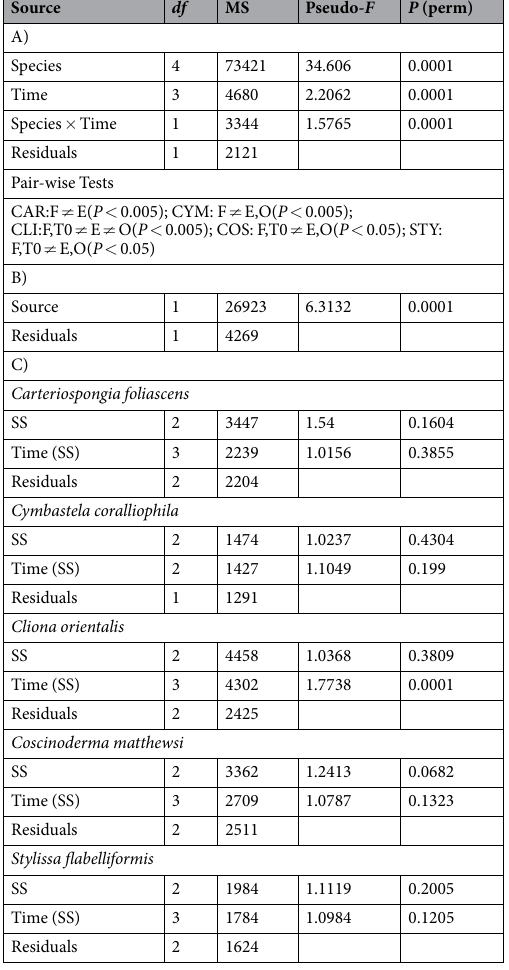
was distinct from the seawater microbiome (Table 3b, Supplementary Figs S5 and S6). Aquarium acclimation (for 4 weeks) did not affect the sponge-associated microbial community of any species (Table 3a) as field controls were not significantly different from Time 0 controls (i.e. samples collected after the acclimation period, right before starting the exposure to sediments) (Table 3a). However, both field/time 0 controls showed significant differences with samples at the end of the experimental/observational period in all species (Table 3a). Elevated SSC did not have a major impact on the overall composition of the sponge microbiome at the phyla level (Fig. 4b) and no significant differences were detected at the OTU level (97% sequence similarity) for any species (Table 3c). In addition, no clear groupings were observed in the ordination (Fig. 4a). The only exception to this microbial stability was in Carteriospongia foliascens , where samples exposed to 100 mg L − 1 exhibited greater dispersion across the ordination (Fig. 4a). Cliona orientalis also showed greater separation between samples at the end of the experimental and observational periods, particularly in the 30 and 100 mg L − 1 treatments (Table 3c, Fig. 4a). Network analyses of the 30 most discriminatory operational taxonomic units (OTUs) for the control (0 mg L − 1 ) and highest SSC (100 mg L − 1 ) in each species revealed phylogenetically diverse and stable core microbi- omes (i.e. the component shared between all samples) as well as treatment specific OTUs (Fig. 4c, Supplementary Table S2). In each species, the number and taxonomy of OTUs observed exclusively in control samples was gen- erally balanced by the number and taxonomy of new OTUs that were observed only in sediment treated samples. A notable exception however was the recruitment of 3 novel Cyanobacteria OTUs in Carteriospongia foliascens within samples from the high SSC. Also of interest was the finding that core Cyanobacteria OTUs in the two photosynthetic species Carteriospongia foliascens and Cymbastela coralliophila are not disrupted by sediments, even at the highest SSC.